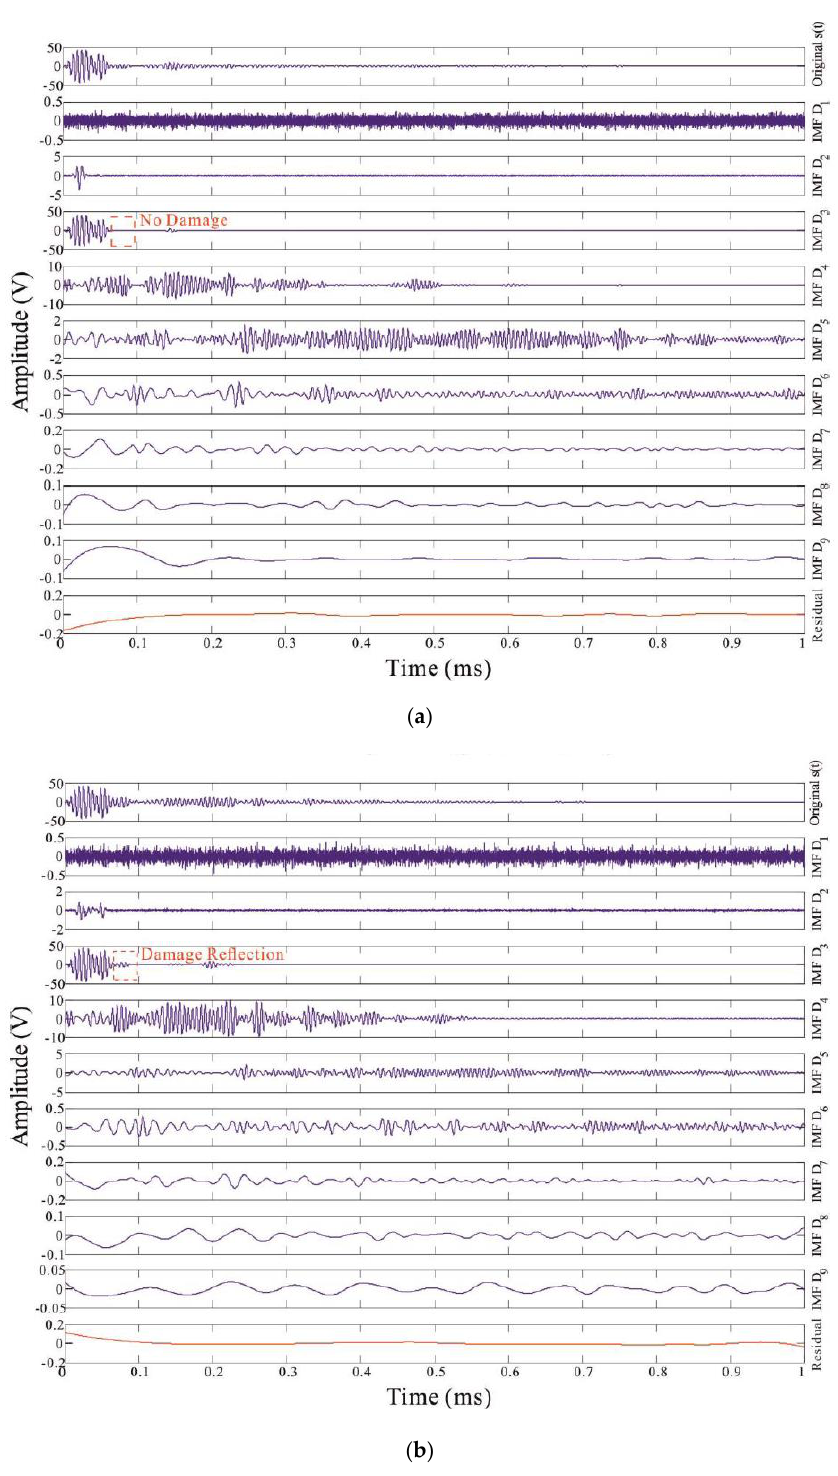
Figure 2. FEEMD processing for the sensor signals without ( a ), and with damage ( b ).